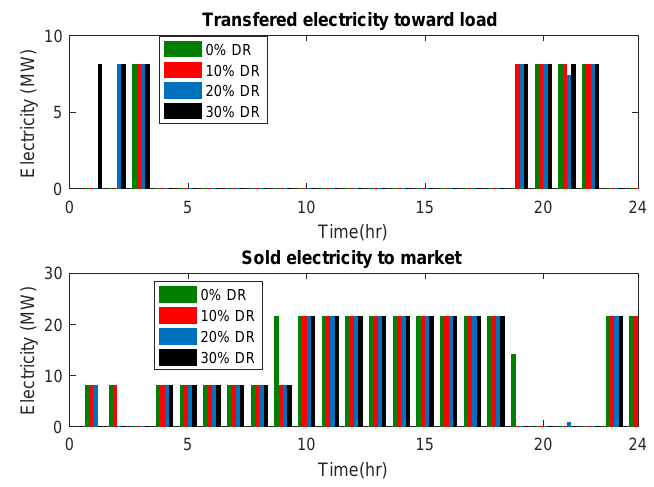
Figure 10. The power generated by the CHP.